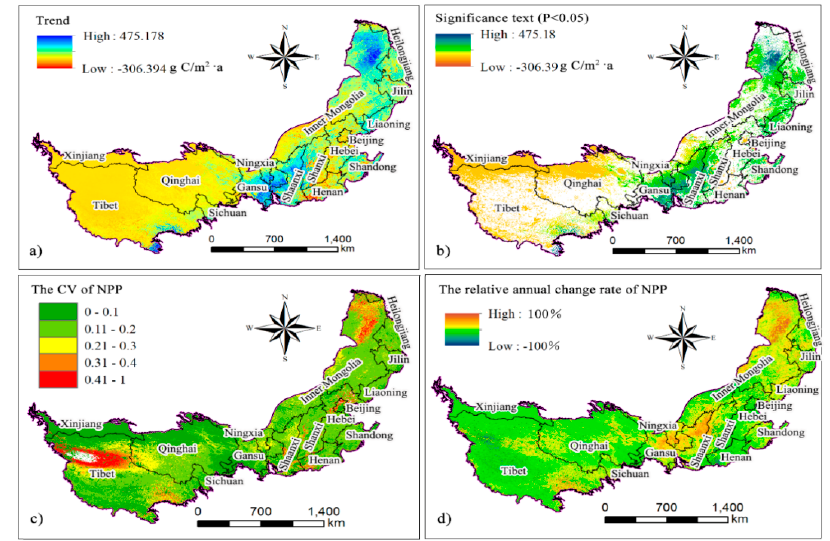
Figure 5. The NPP variation trends ( a ), F significance test ( b ), CV of NPP ( c ), and relative annual rate of change in NPP ( d ).